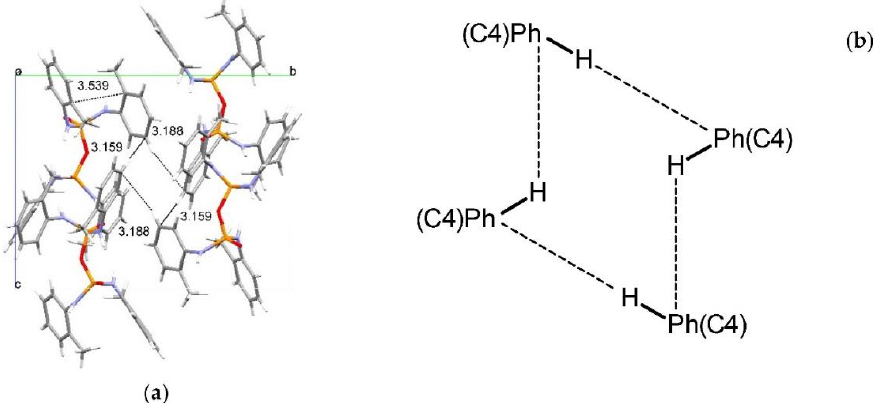
Figure 6. ( a ) O((2-MePhNH) 2 PO) 2 polymorph published by Pourayoubi et al. showing both intermolecular and intramolec- ular C–H ··· Ph interactions (generated in Mercury [25]); ( b ) a diagram of the intermolecular C–H ··· Ph interactions for clarity (generated using ChemSketch